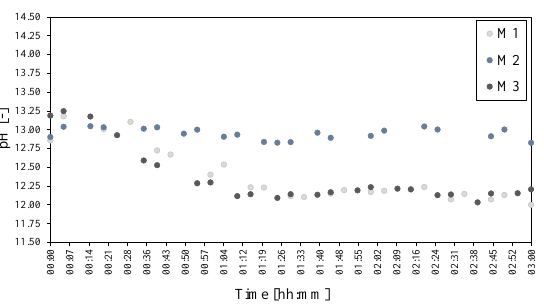
Figure 21. pHs of the mixing series of LDHs M1 = 500rpm, M2 = 750rpm and M3 = 1000rpm. The pH was adjusted to 25 ◦ C to facilitate comparison.